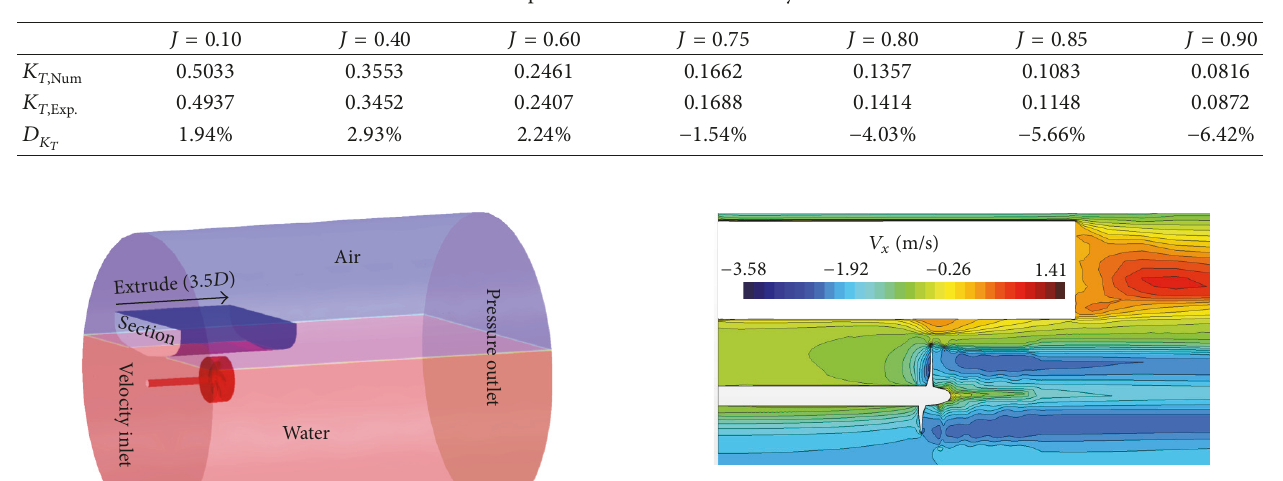
Table 6: Validation of predicted thrust coefficient by measured results.